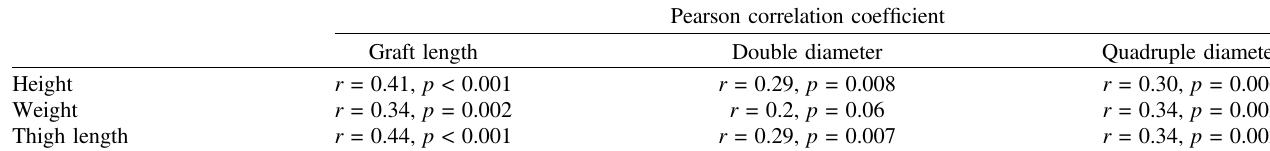
Table 3. Correlation between graft parameters and height, weight and thigh